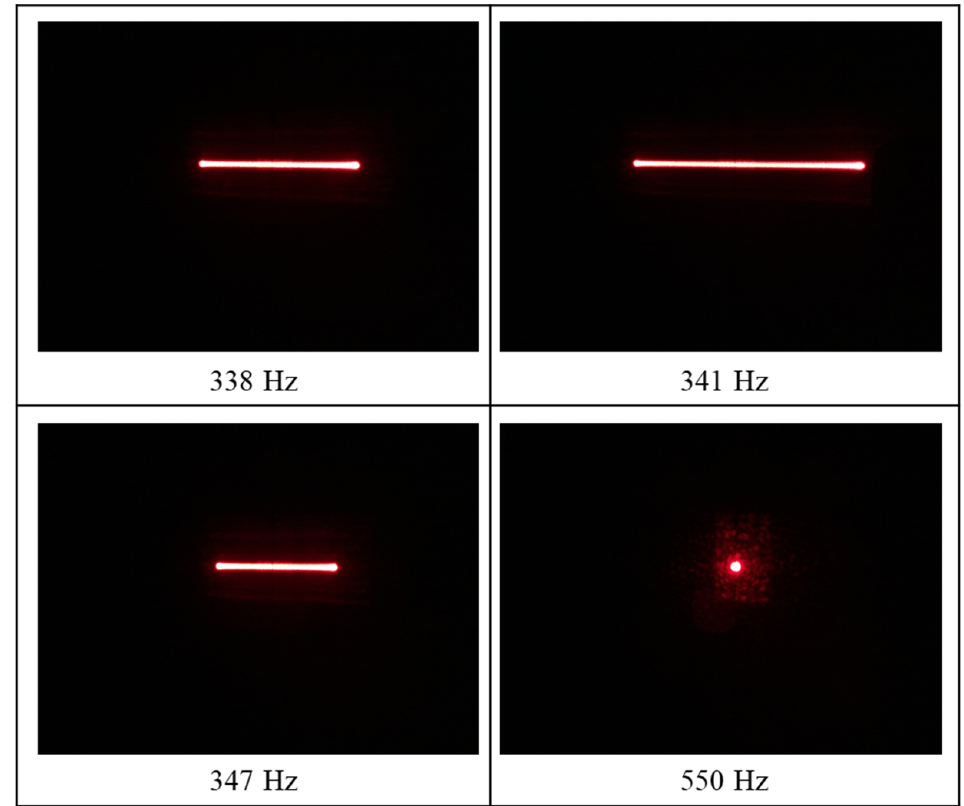
Figure 8. Traces of the reflected light spot on the screen of Device D at several selected frequencies, including the resonance frequency 341 Hz.